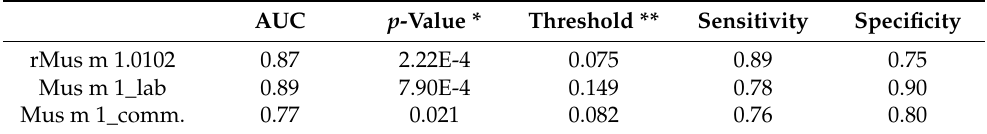
Table 3. Test accuracy parameters for indirect